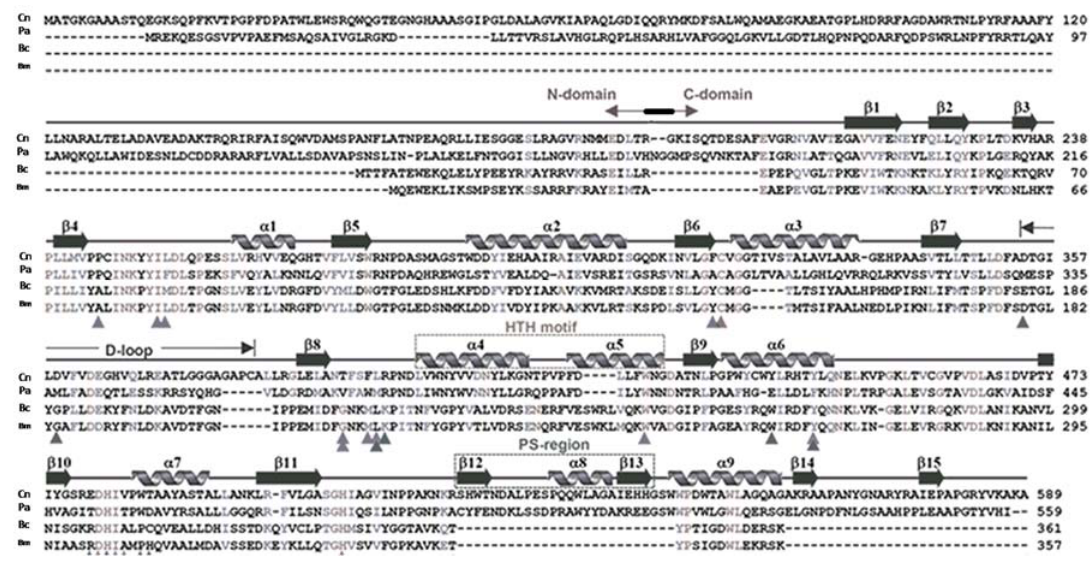
Figure 1. Amino acid sequence and secondary structure of Cupriavidus necator PhaC Cn , aligned with the PHA synthase of Class II ( P. aeruginosa ), Class IVm and Class IVb, from Bacillus megaterium and B. cereus , respectively.